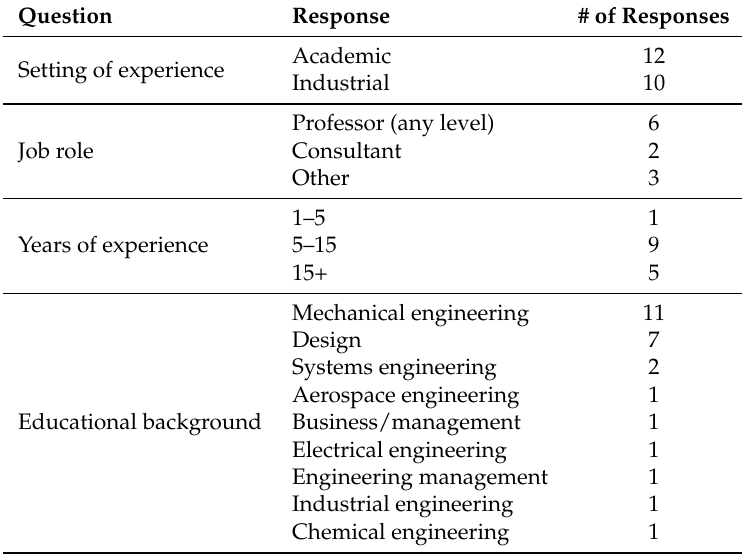
Table 7. Respondents’ experience and backgrounds ( n =